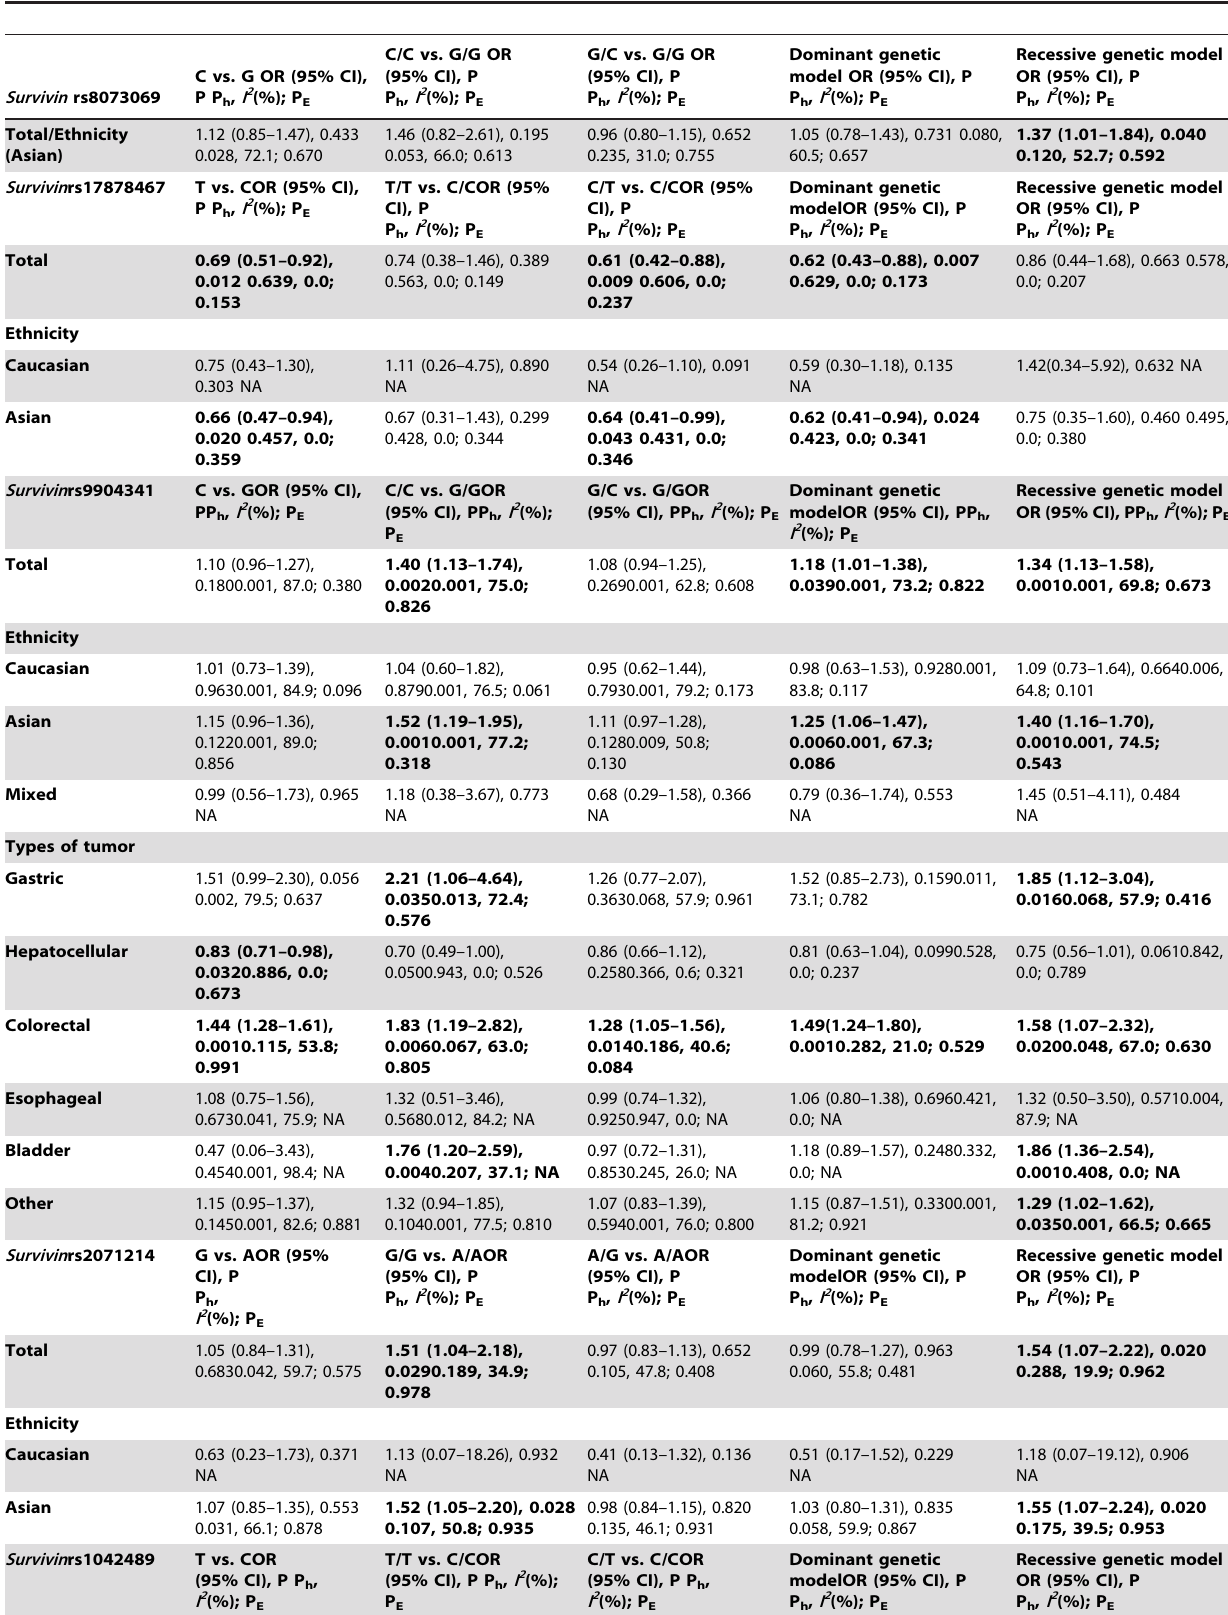
Table 2. Meta-analysis results of survivin polymorphisms and tumor risk.